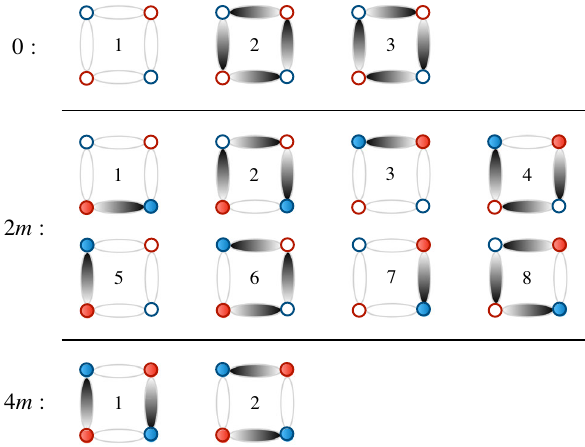
FIG. 17. Graphic representation of the basis vectors, in each mass sector, used to build up the 2 × 2 LGT Hamiltonian in the S ¼ 1 representation, as outlined in Appendix